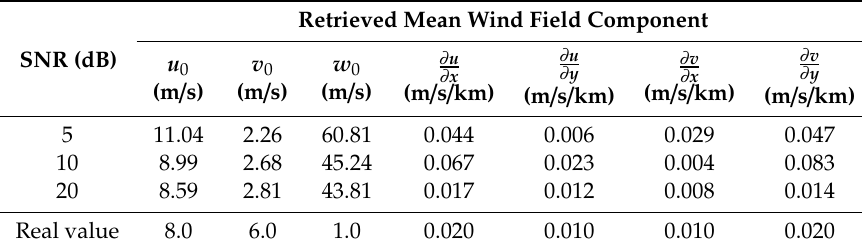
Table 3. Performance analysis of linear wind field retrieval.